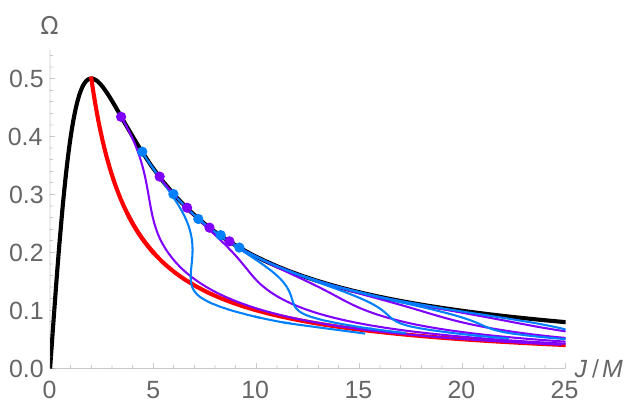
Figure 6 . Phase diagram for axisymmetric solutions, we show the 10 (cid:12)rst appearing branches: ring-branches are shown in purple, and Saturn branches in light-blue. The Myers-Perry and black bar solutions are also plotted by the black and red curves. We do not expect the Saturn branches to terminate, but they become harder to construct for low